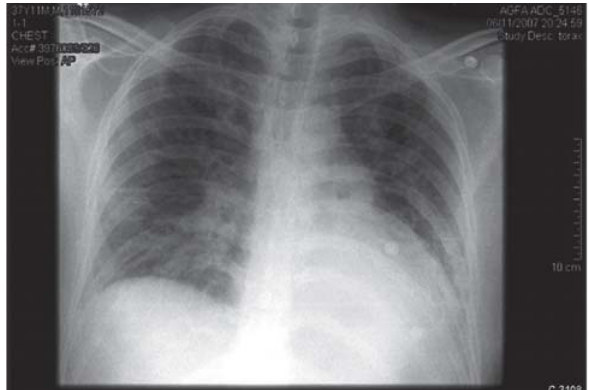
Fig. 1 - A significant pulmonary venous congestion, particularly in the peri-hilar region of both lung fields, and with a moderate enlargement of cardiac